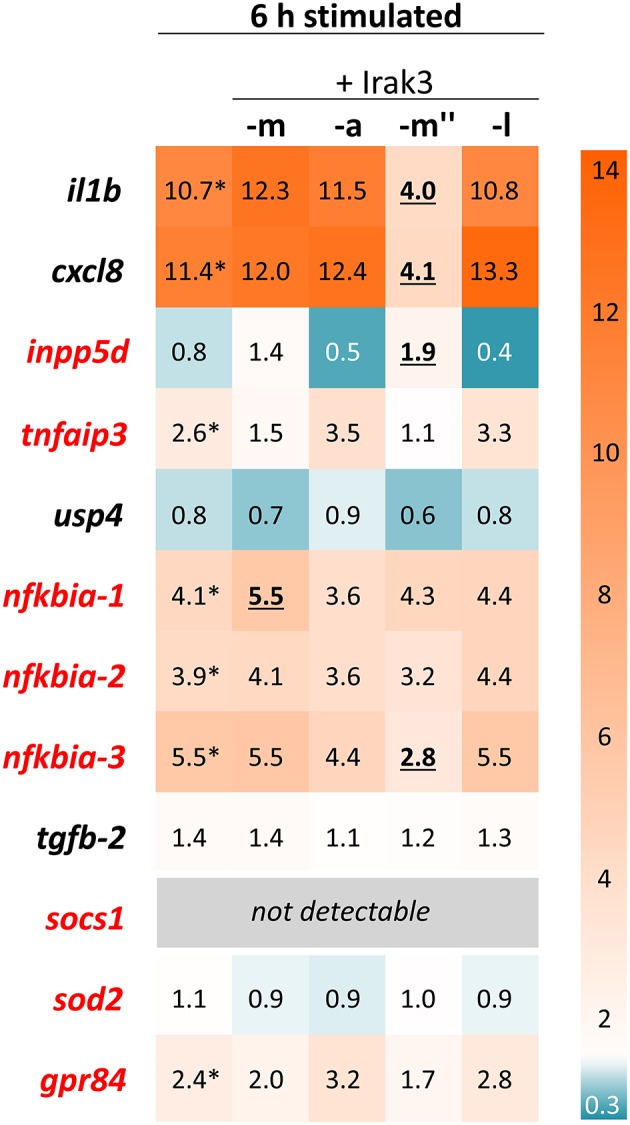
Expression profiling of stimulated Irak3-overexpressing CHSE-214 cells. The HeatMap illustrates the averaged fold-change values (according to the legend on the right) of the mRNA concentrations measured in CHSE cells 6 h after stimulation with 10 μg/ml poly (I:C) and 100 ng/ml flagellin, relative to unstimulated control cells (set as 1.0). The quantified transcripts are listed as gene symbols on the left; orthologs whose expression is IRAK3-dependent in mammals according to Zhou et al. (5) are highlighted in red. Significant copy-number changes (p < 0.05) of stimulated vs. non-stimulated untransfected cells are marked with asterisks; significant copy-number changes of stimulated non-transfected vs. transfected cells are underlined. All expression values were normalized against the geometric means of the reference genes eef1a1 and rps5.